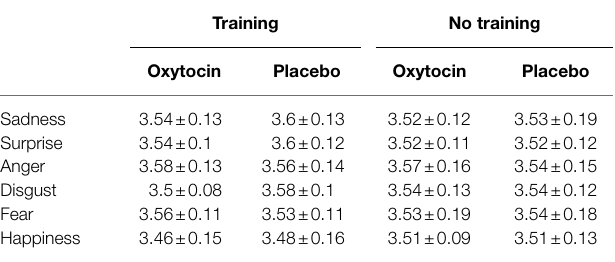
TABLE 7 | The RT (log transformed) of natural micro-expression recognition task in Study 3 (M ± SD). Training Oxytocin Placebo